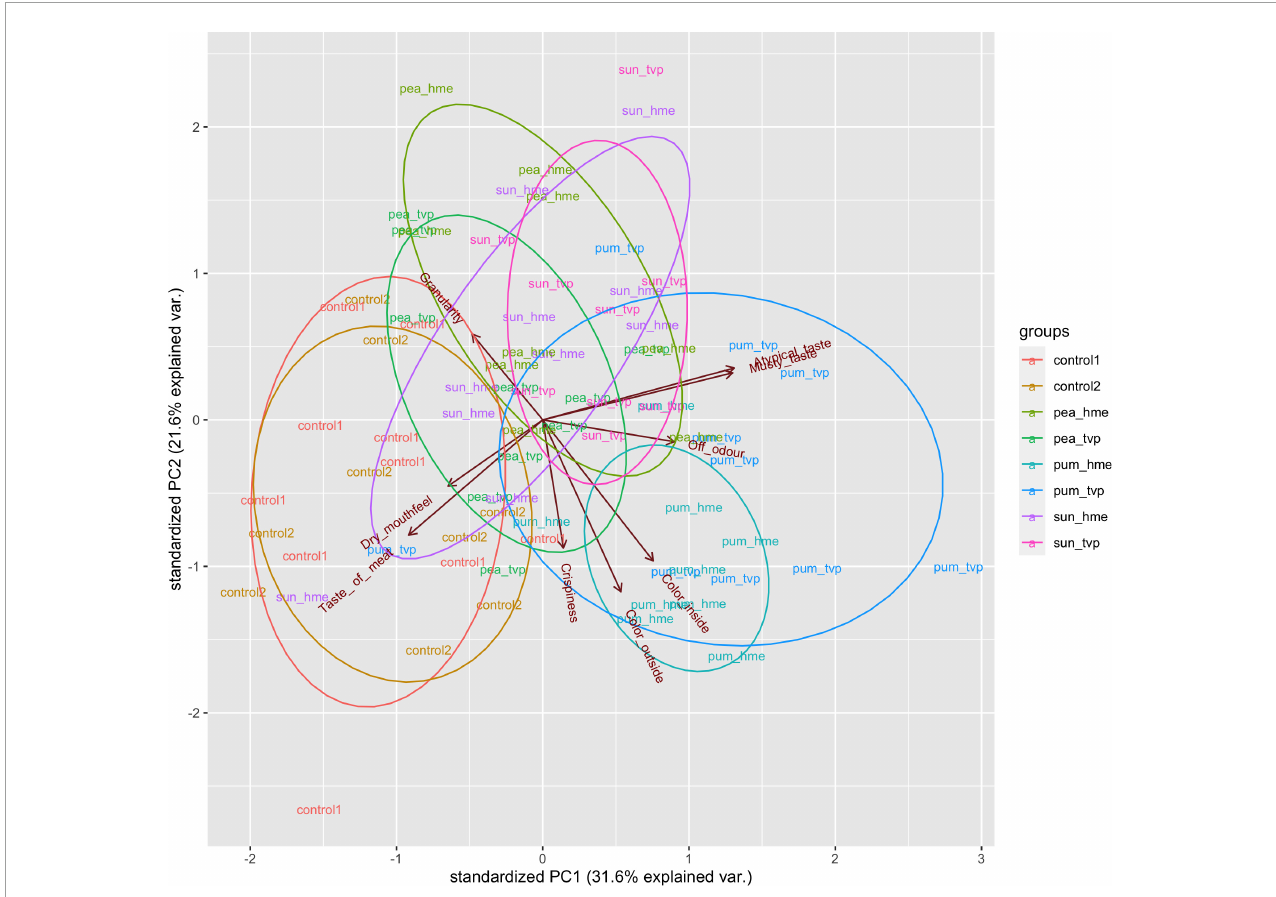
FIGURE1 Principal component analysis of the sensorial results. pea_hme, Pea HME; pea_tvp, Pea TVP; pum_hme, Pumpkin HME; pum_tvp, Pumpkin TVP; sun_hme, Sunflower HME; sun_tvp, Sunflower